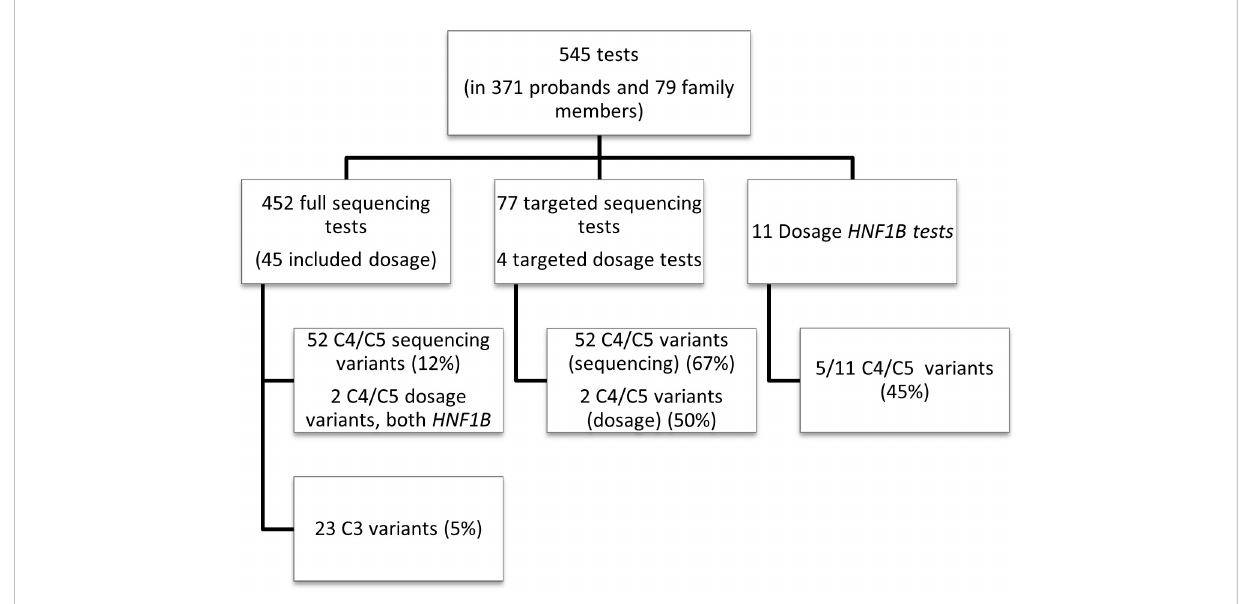
FIGURE 1 Overall test breakdown. Overview of the LabPlus testing for monogenic diabetes January 2014 – December 2020, using Sanger sequencing, and CGH array for dosage testing. 116 tests were also sent to Exeter for wider panel testing using NGS. C4/C5 = likely pathogenic/pathogenic variant, as de fi ned by ACMG. C3 = Variant of uncertain signi fi cance, as de fi ned by